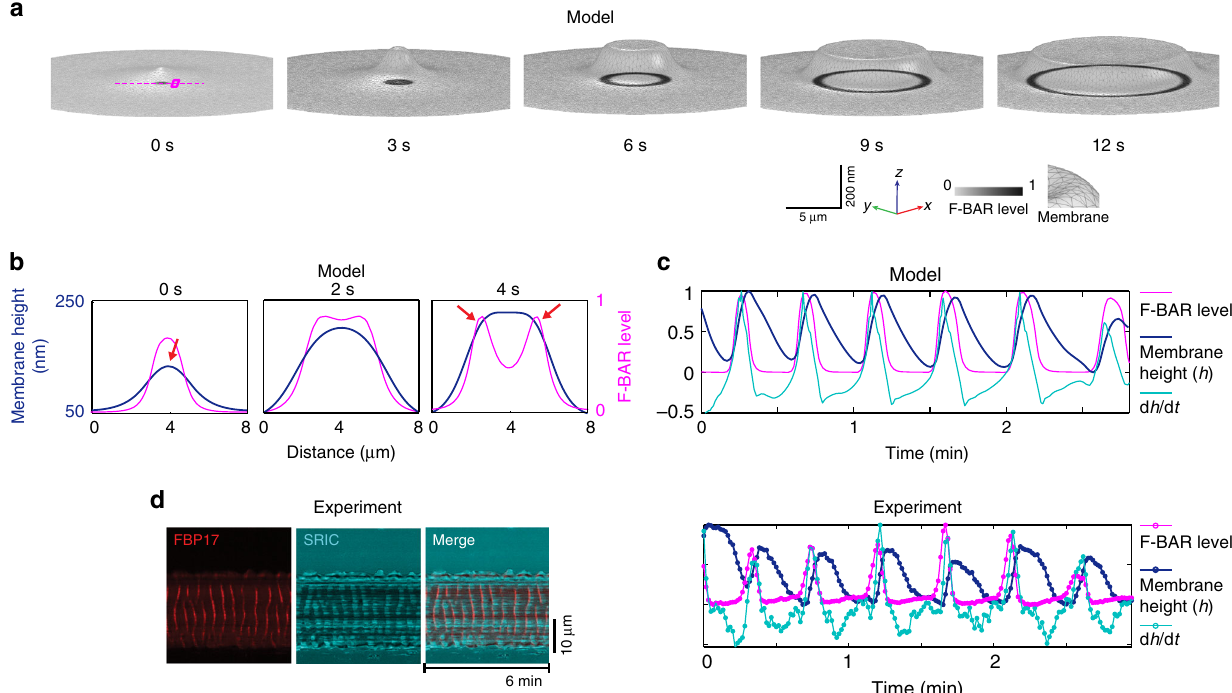
Fig. 2 Membrane shape changes accompany traveling wave propagation. a Model predicts that the local membrane shape correlates with the F-BAR cortical density at the wavefront during wave propagation. The grayish meshes represent the membrane shapes in three-dimensional space ( X , Y , Z ) with a perspective angle; the inverted density maps are the corresponding F-BAR densities on the membrane, which is projected onto the two-dimensional X – Y plane. The scale bar for the x – y dimension is 5 μ m and for the z -dimension is 200 nm. For the purpose of demonstration, the snapshots in Fig. 2a only show a part of the simulated membrane patch. The wave propagates beyond the domain de fi ned in the snapshots until it approaches the boundary of the membrane patch; there, the wave subsides and eventually disappears, as the local membrane is clamped (Supplementary Movie 2 and Supplementary Fig. 2). b A zoom-in view of the local cortical rhythm along the magenta dash line across the cortex marked in Fig. 2a at t = 0, 2, and 4 s. Blue lines: local membrane shape. Magenta lines: F-BAR cortical level. The red arrows mark the locations with the largest membrane curvature. c Model prediction on temporal evolutions of the local F-BAR cortical level, membrane height, and rate of membrane height changes (d h /d t ) at the location of the magenta square in Fig. 2a. d Experimental measurement of the spatial-temporal changes in F-BAR cortical level (by TIRFM) and membrane height (by SRIC) during traveling wave propagation. Left: kymographs of the local F-BAR cortical level and the corresponding relative membrane height. Right: time curves representing the local F-BAR cortical level, membrane height, and the rate of membrane height changes (d h /d t ) at a fi xed location. From SRIC measurements, we estimate the maximum membrane height to be ~140 nm (Supplementary Fig. 3). Note that this number is a very rough estimate, as the refractive indexes both inside and outside of the cell may undergo variation, due to changes in salt concentration and the organelle proximity. We therefore used the normalized membrane height in the experimental plot to avoid systematic